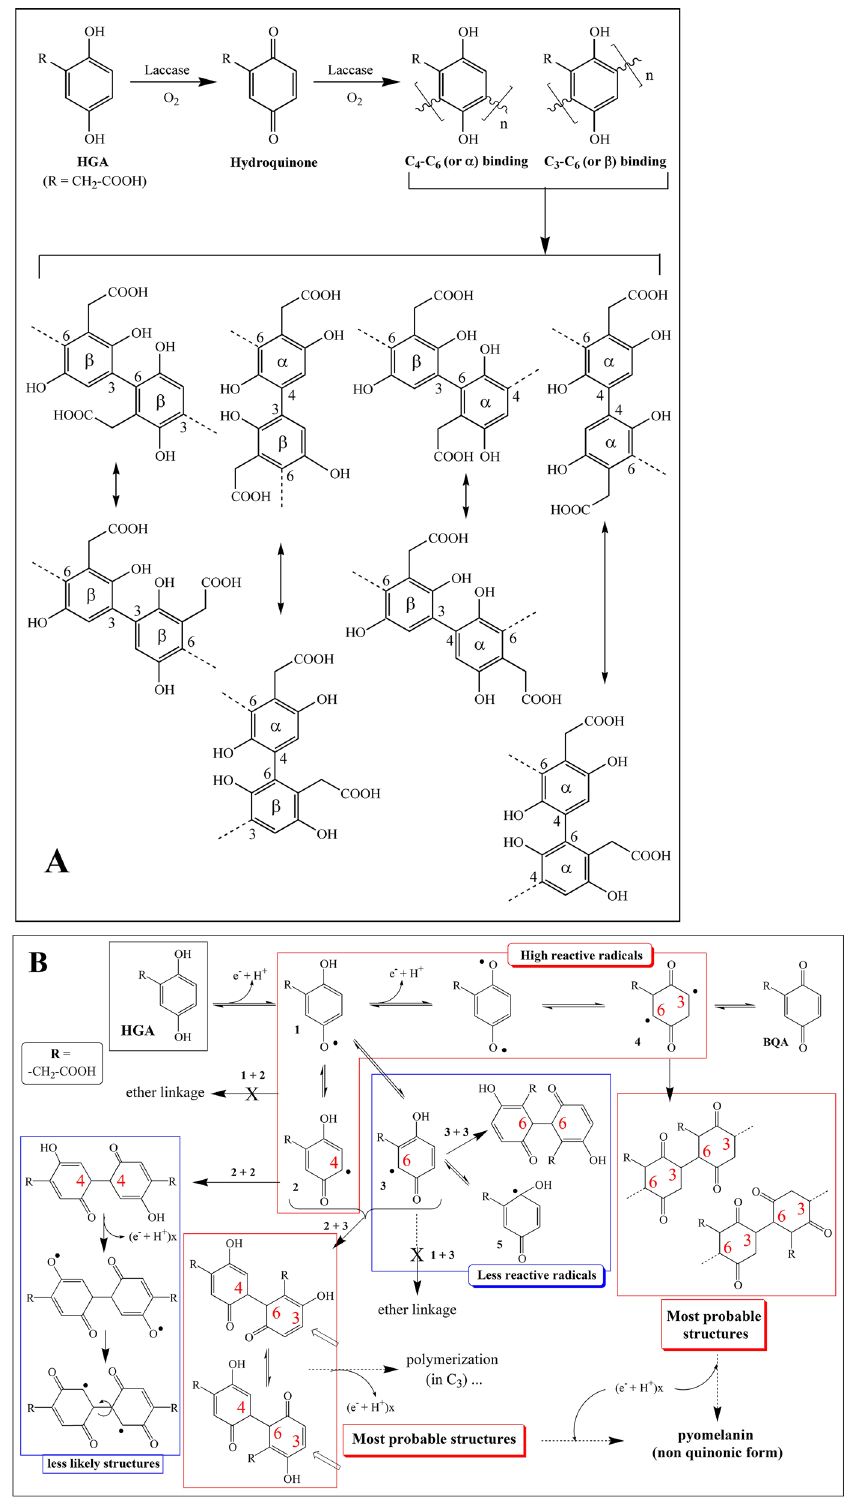
Figure 4. The proposed mechanism of HGA polymerization by the laccase or in abiotic conditions, giving the most probable structure in ( A ) and the most active radical reactions detailed in ( B ). These two figures show the configurations of the C ar -C ar links present in the three pyomelanin structures, whereas C ar -O-C ar (ether) links are absent as demonstrated by 13 C solid-state NMR (see text). In these structures, gentisyl alcohol (major) and gentisaldehyde (minor) issued from the decarboxylation mechanism (laccase process, bacteria) are supposed to be incorporated into the polymer in the same manner as HGA radicals at locations of the chain that could not be determined at this